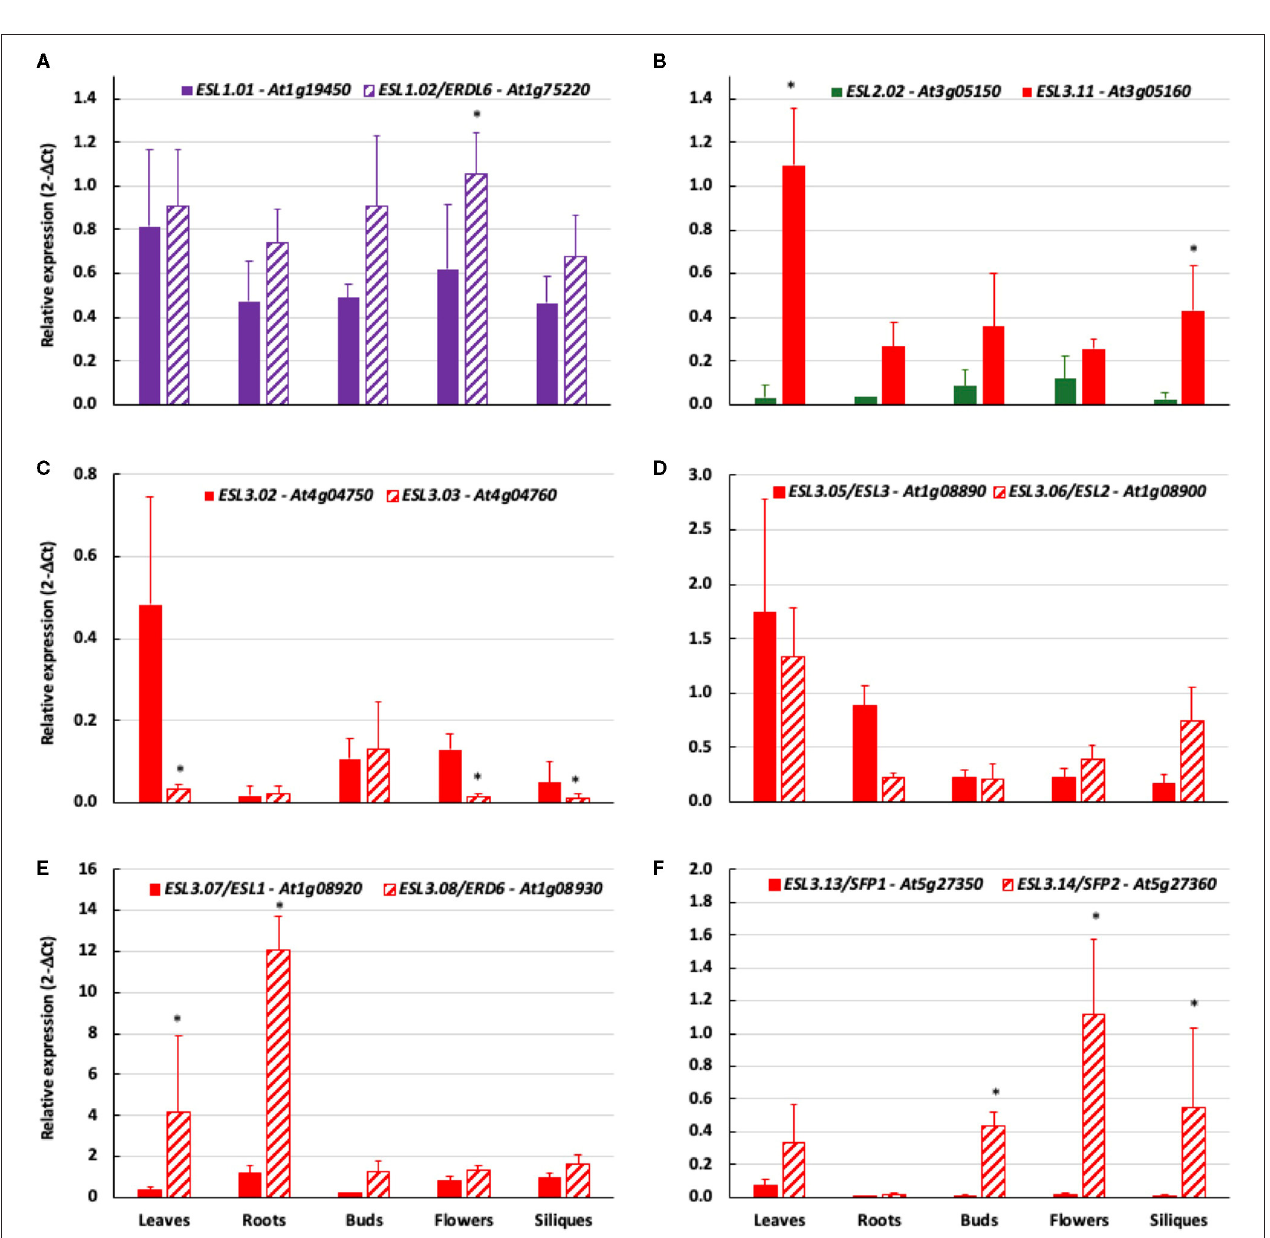
FIGURE 12 | The comparison of the relative expression of tandem duplicated ESL genes in different organs measured by qRT-PCR. 2 − 1 Ct values are normalized according to AtPP2a expression and represent the mean of three biological repeats ( ± ecartype). Statistical analysis was performed by using the Kruskal–Wallis test and the multiple comparison test of Dunn corrected by Bonferroni. Values significantly different are indicated by distinct letters. (A) ESL1.01/ESL1.02 , (B) ESL2.02/ESL3.11 , (C) ESL3.02/ESL3.03, (D) ESL3.05/ESL3.06, (E) ESL3.07/ESL3.08 , and (F) ESL3.13/ESL3.14